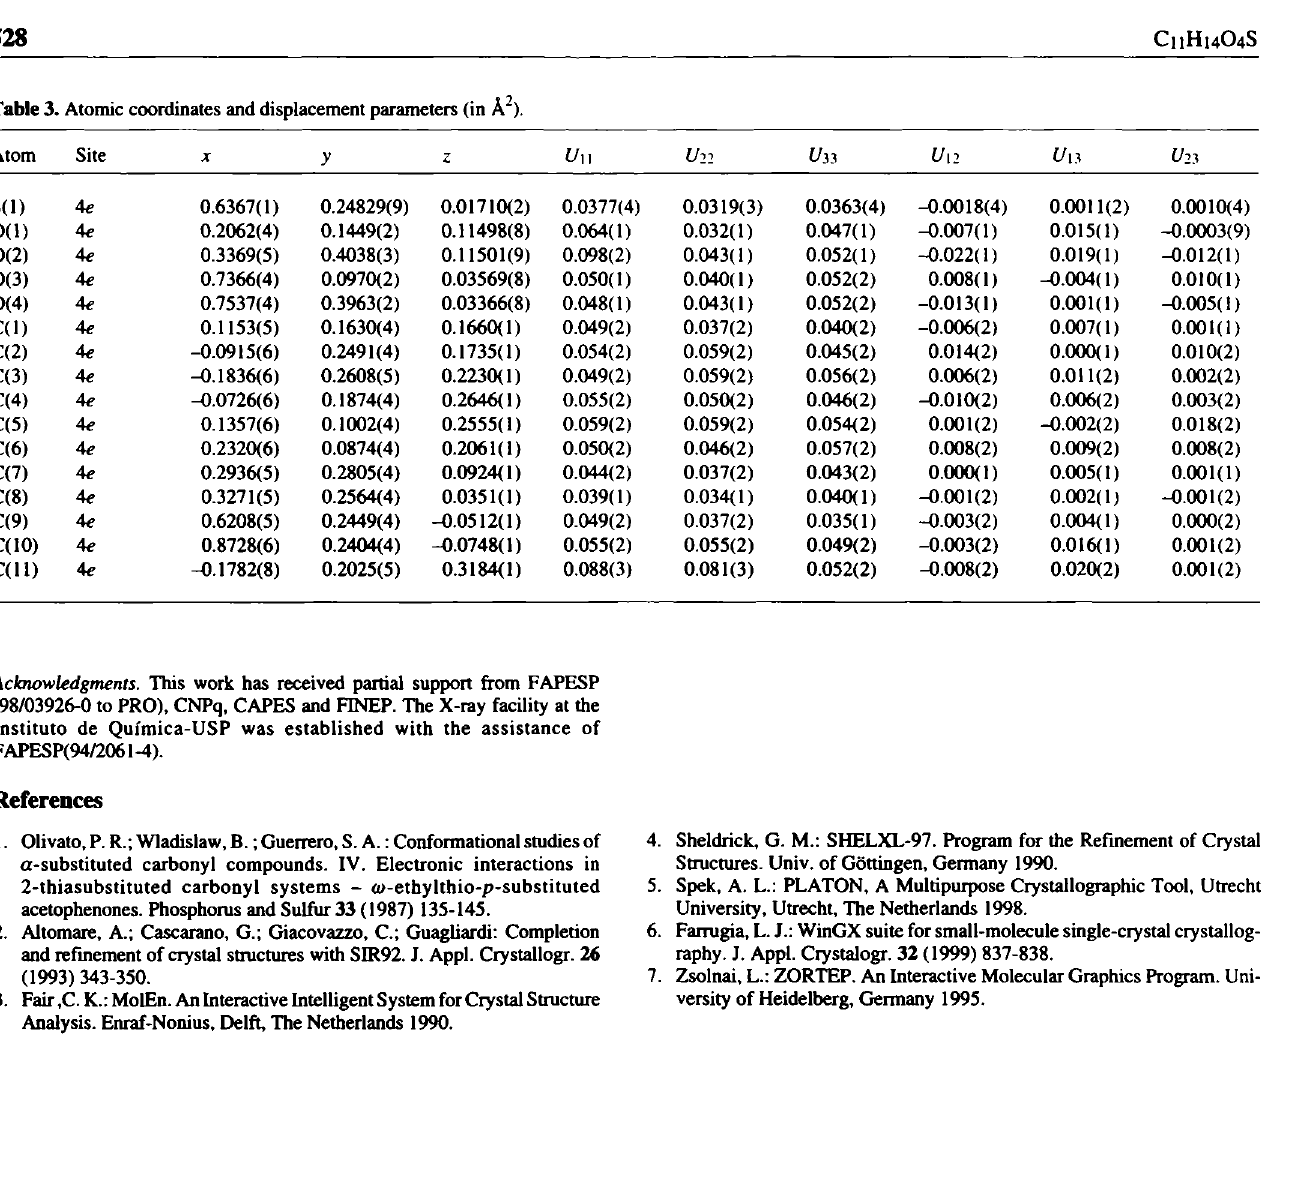
Table 3. Atomic coordinates and displacement parameters (in À 2